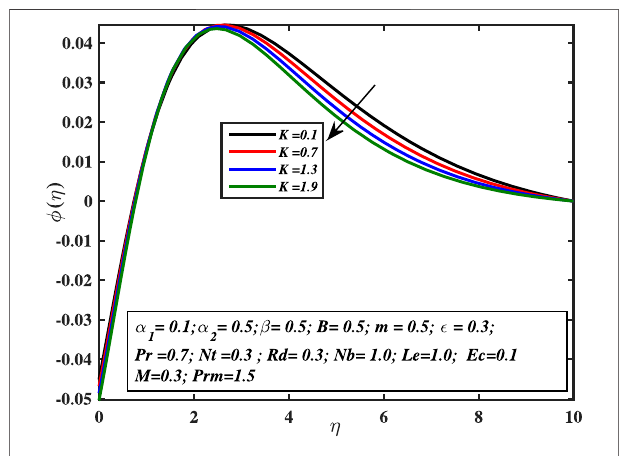
FIGURE 16 | Effect of K on the ϕ ( η ) pro fi le.